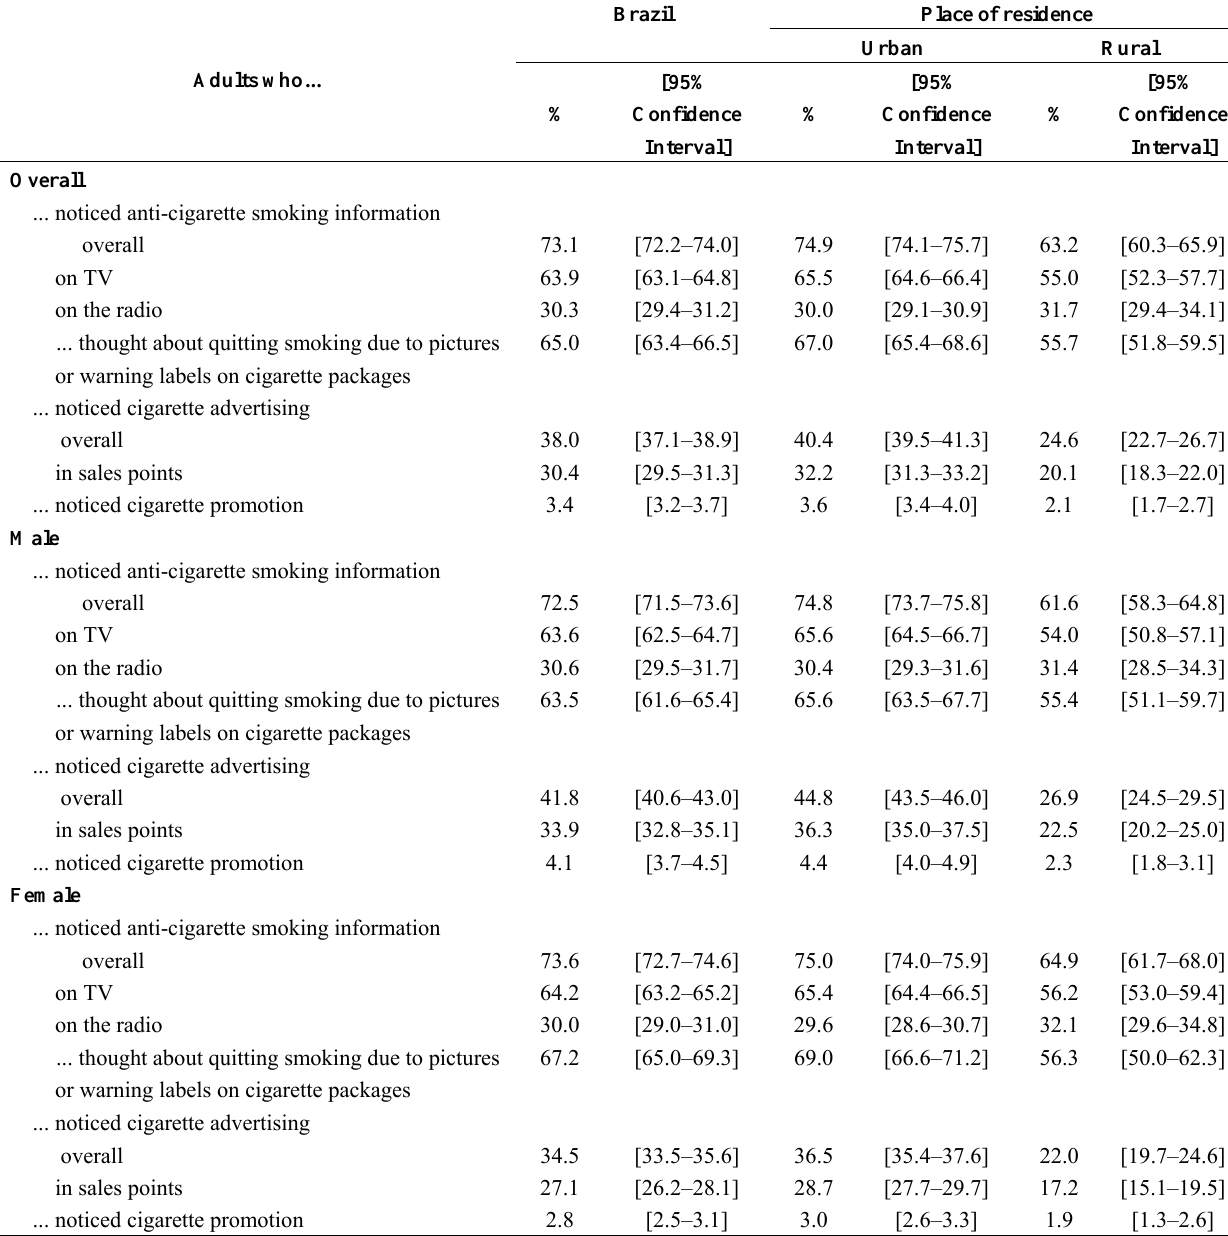
Table 6. Percentage of adults ≥ 15 years old who noticed anti-cigarette smoking information and cigarette advertising during the 30 days before the interview date and, by place of residence and gender, GATS Brazil,